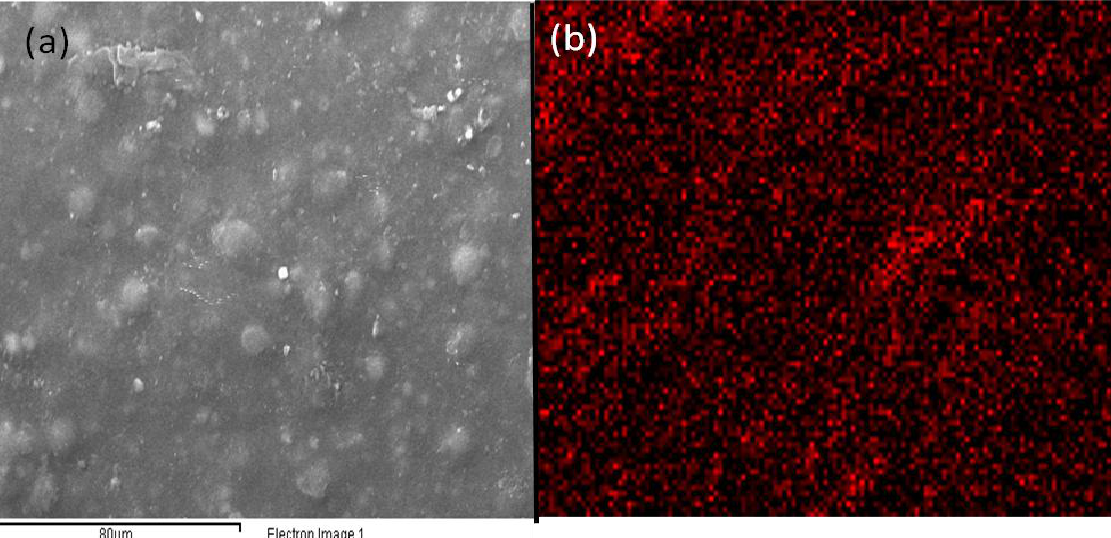
acrylic dispersion and ( b ) SEM-EDS of titanium 2